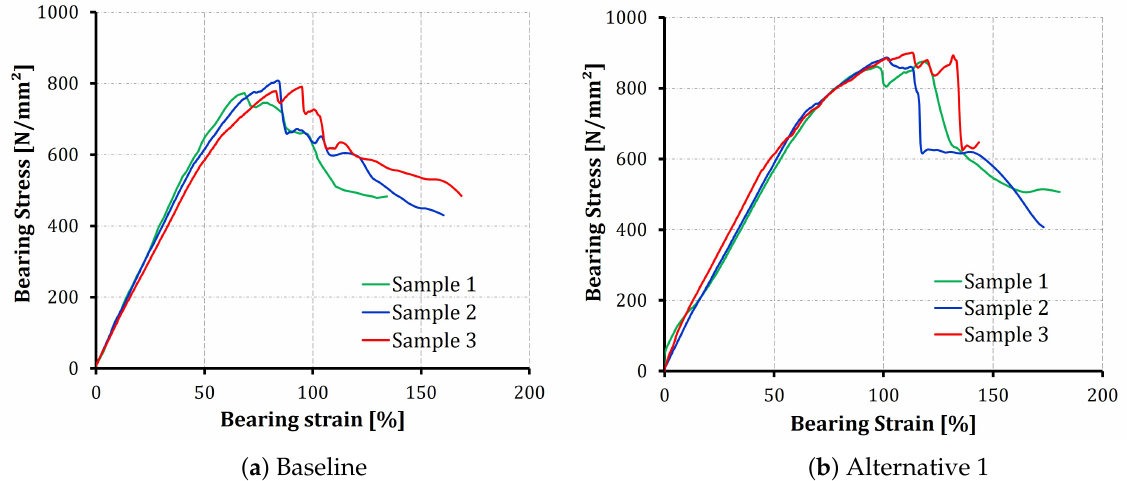
Figure 4. Bearing stress-bearing strain curves of the baseline and the A1 configurations.